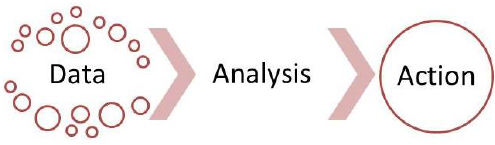
Figure 1. Learning analytics cycle.